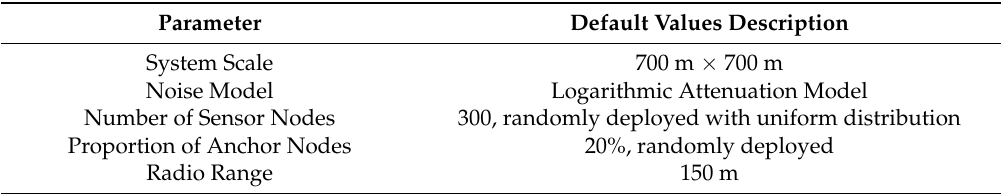
Table 1. Default simulation